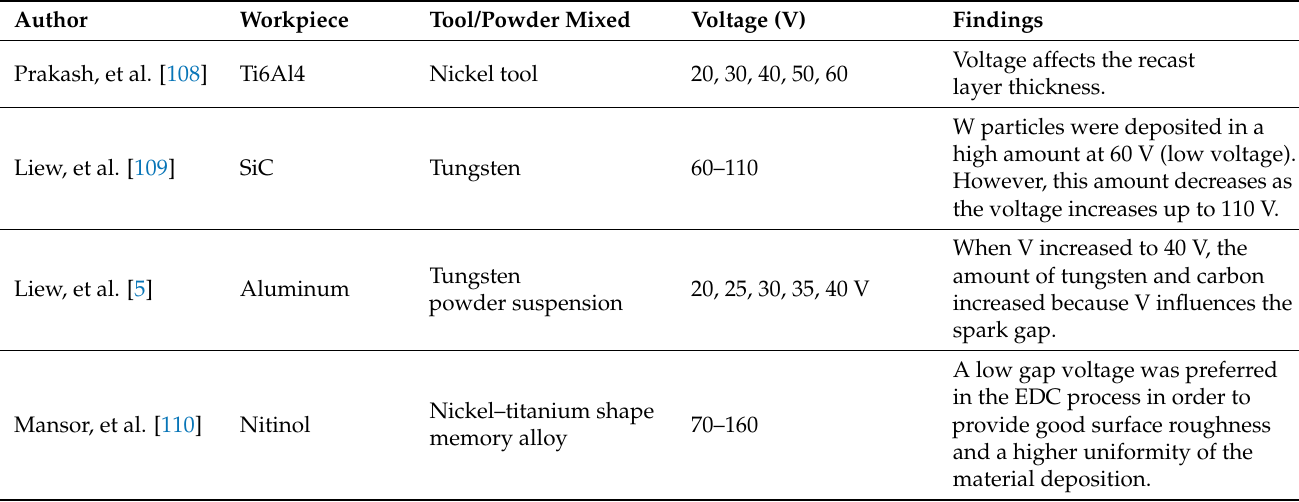
Table 3. The summary of past literature work on the effect of the